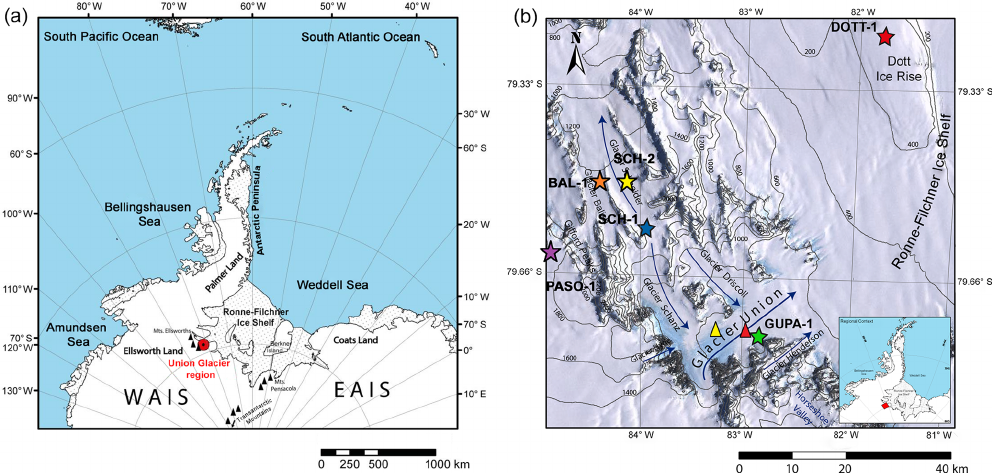
Figure 1. Location of the UG region within Antarctica (a) and location of the drill sites of the six firn cores (GUPA-1, DOTT-1, SCH-1, SCH- 2, BAL-1, PASO-1) within the UG region (b) . The triangles in (b) denote the location of two AWSs on UG (yellow: station Wx7; red: station Arigony; further explanations in the text). The background image in (b) was extracted from the Landsat Image Mosaic of Antarctica (LIMA), and the contour lines were obtained from the Radarsat Antarctic Mapping Project Digital Elevation Model, Version 2 (Liu et al., 2015).